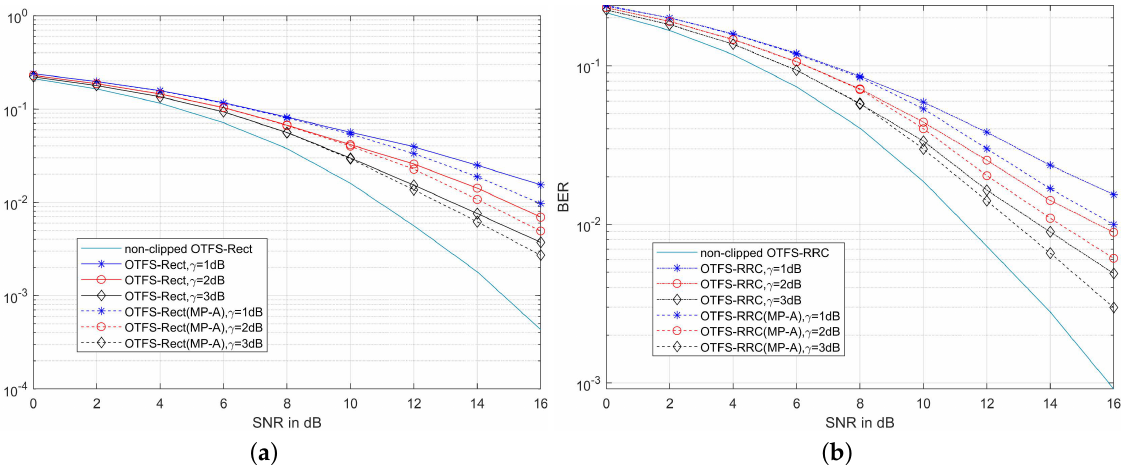
Figure 6. ( a ) BER performance of the MP-A [26] method in the clipped OTFS-Rect system on the channel with a maximum Doppler shift of 1935.48 Hz; ( b ) BER performance of the MP-A [26] method in the clipped OTFS-RRC system on the channel with a maximum Doppler shift of 1935.48 Hz (( α =